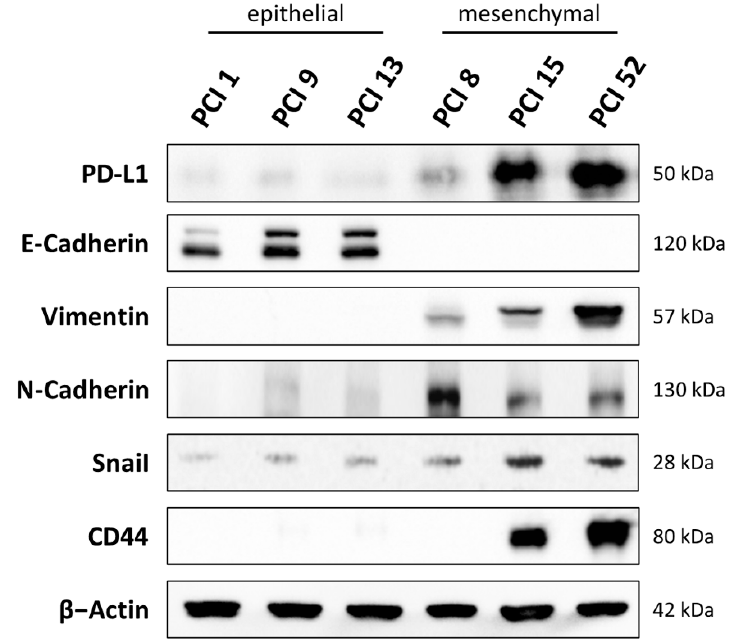
Figure 1. Characterization of HNSCC cell lines. The basal expression of PD-L1, E-cadherin, vimentin, N-cadherin, CD44, and Snai1 of the HNSCC cell lines PCI 1, 9, 13, 8, 15, and 52 were investigated in a WB analysis. The cells were harvested in a sub-confluent condition. β -actin served as a loading control. Thirty milligrams of total protein lysate were used. Based on these markers, cells were divided into epithelial and mesenchymal differentiation status. Original western blots in supplementary Materials S1.